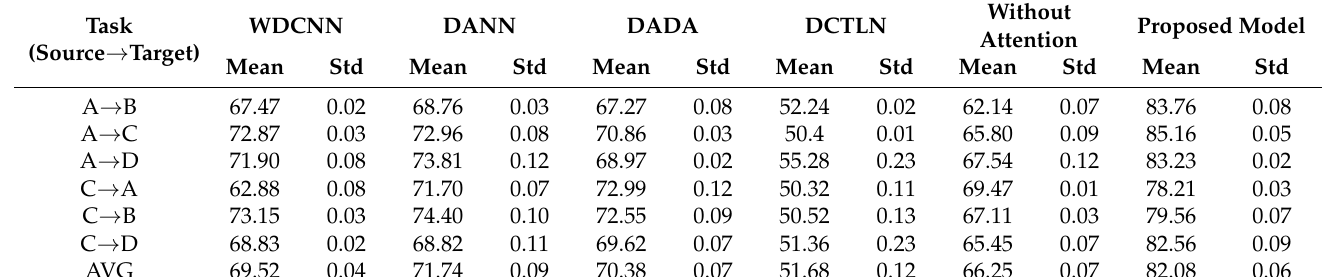
Table 8. The comparison accuracy of classification results on the real machine dataset.